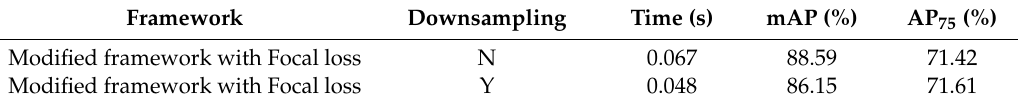
Table 5. Results of the modified framework with focal loss with and without downsampling.